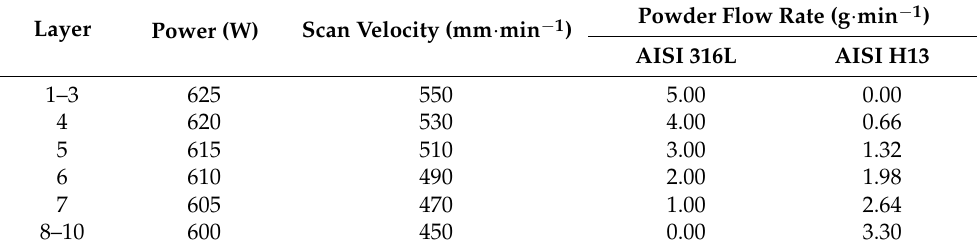
Table 3. L-DED parameters employed.